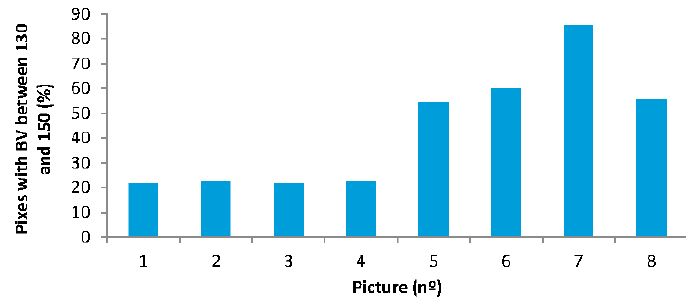
Figure 23. Data gathered by the feed falling sensor.